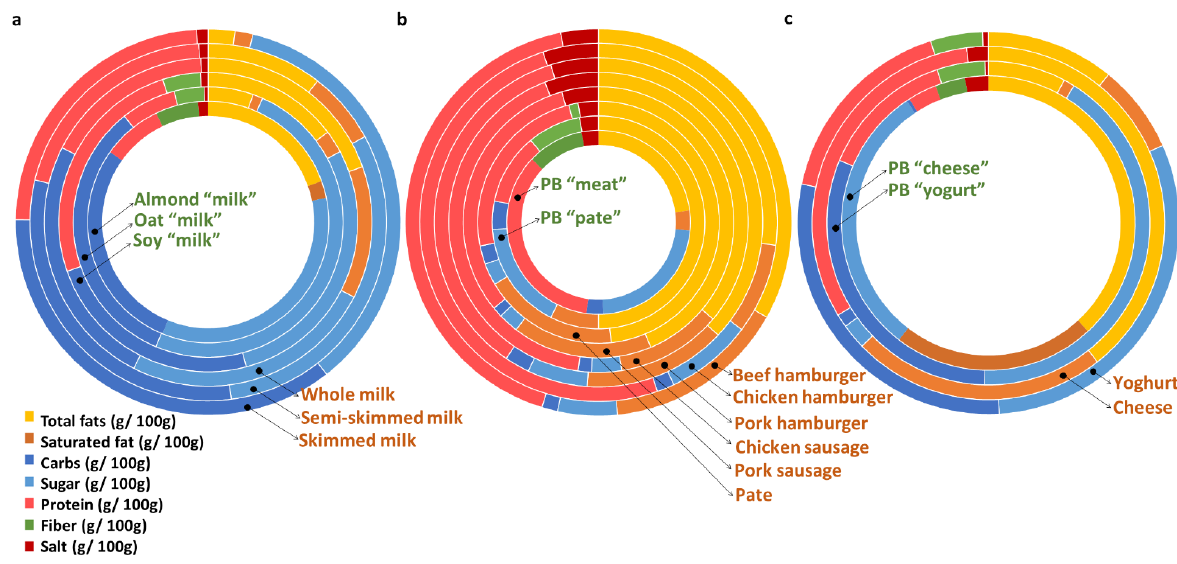
Figure 2. Nutrient profile of the PB (in green colour) and AB foods (in orange colour) relative to 100 g or 100 mL: ( a ) group of beverages including PB “milk alternatives” (almond, oat, and soy “milk”) and AB milk (whole, semi-skimmed, and skimmed cow milk) items; ( b ) PB “meat alternatives”, PB “pate alternatives”, and AB hamburgers and sausages (beef, chicken, or pork based); ( c ) PB and AB dairy products (yoghurt and cheese), excluding milks. Each circle represents one type of food, while the different colors of lines represent the grams of nutrient per 100 g of product, as indicated in the legend, in dry weight. The percentage range of water per food group is: ( a ) 84 – 91%; ( b ) 52 – 70.5%; ( c ) 37.09 – 46.44% per cheese products; and 73.01 – 77.39% per yoghurts.